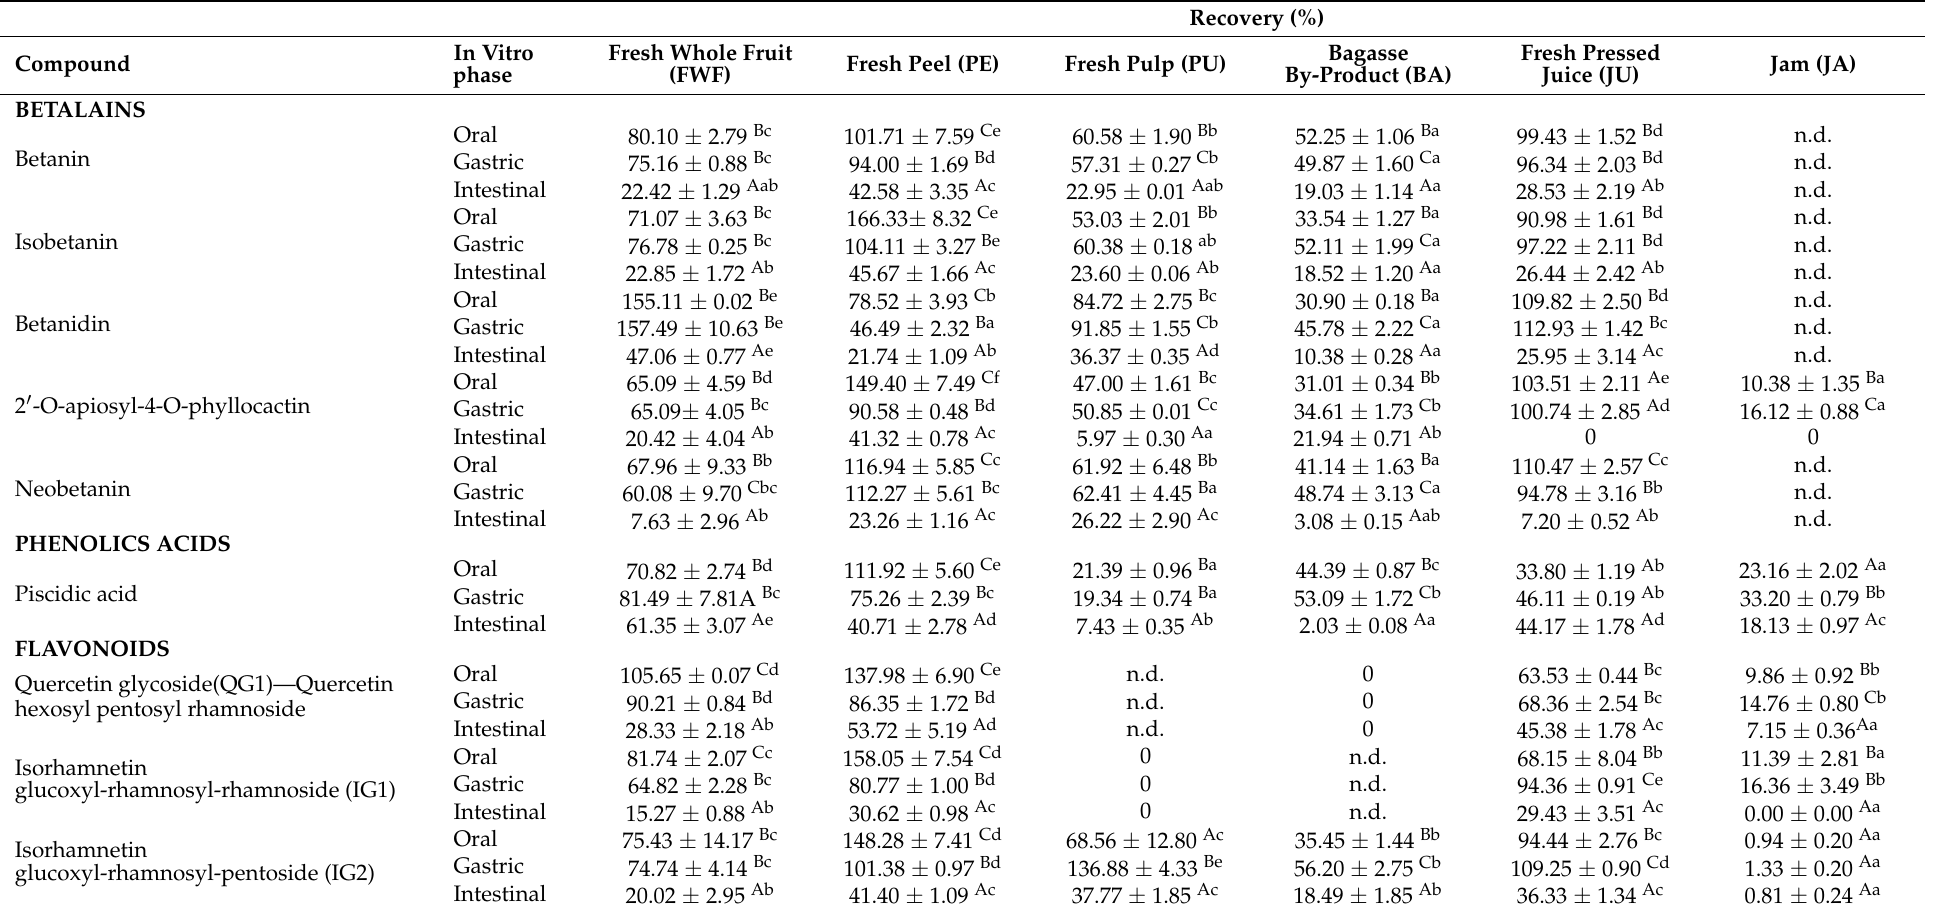
Table 2. Recovery (%) of the most abundant betalain and phenolic compounds in Opuntia stricta var. Dillenii fruit tissues (peel, pulp, and whole fruit). Jam production products (intermediate juice and jam) and by-products (bagasse) during in vitro gastrointestinal static